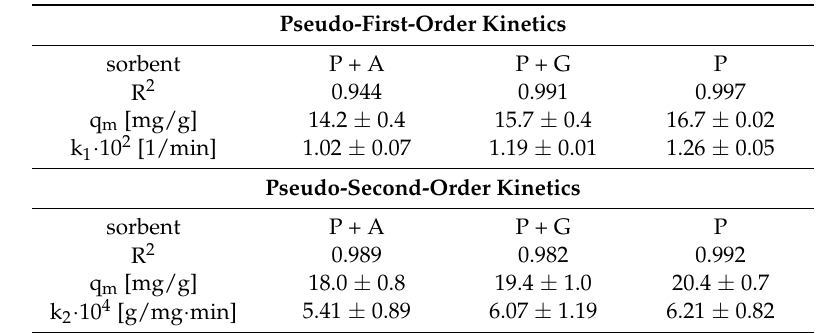
Table 1. Estimated parameters of pseudo-first and pseudo-second order adsorption kinetics model of zinc(II) ions sorption on pectin-based biosorbents (P + A—hybrid pectin biosorbent with agar, P + G—hybrid pectin biosorbent with guar gum, P—sole pectin biosorbent).